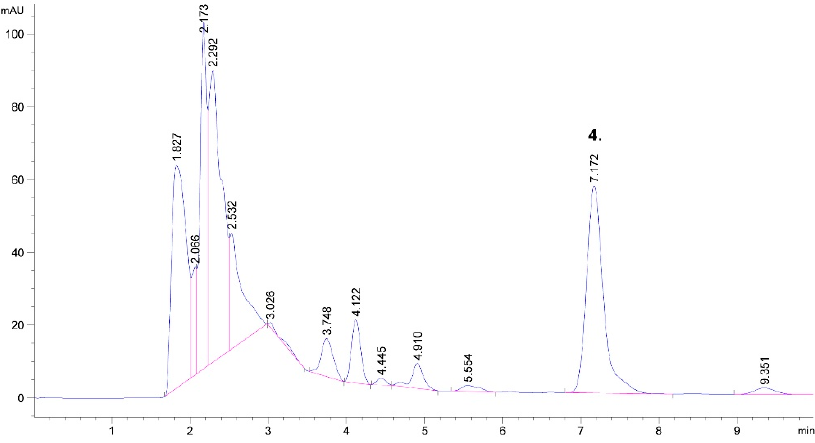
Figure 2. The chromatogram of solanesol in tobacco waste (scrap): Run 1.